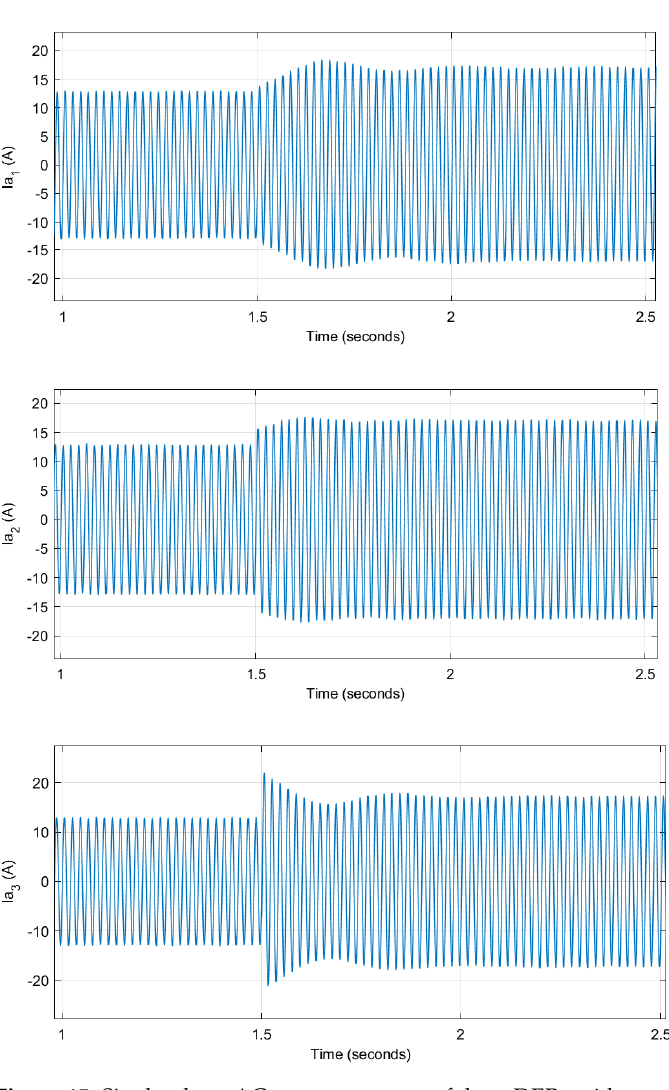
Figure 15. Single-phase AC output currents of three DERs with proposed virtual impedance.